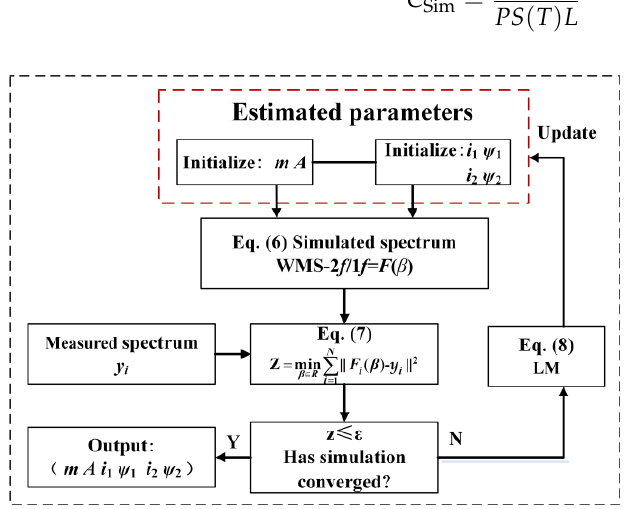
Figure 1. Flow chart of LM-based spectral fitting.